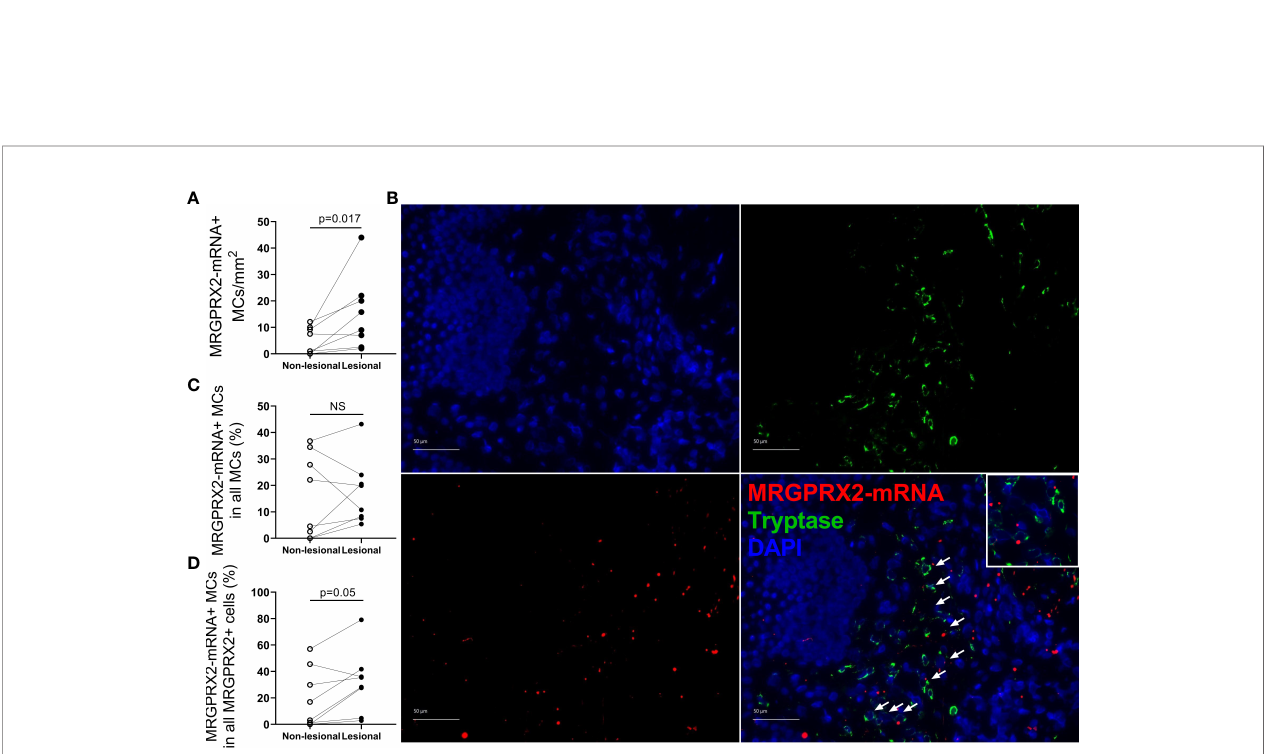
FIGURE 3 | The number of MRGPRX2-mRNA-expressing mast cells is increased in lesional skin of patients with indolent systemic mastocytosis. (A) Number of MRGPRX2-mRNA+ MCs in lesional and non-lesional skin of ISM patients. (B) In situ hybridization (MRGPRX2-mRNA) (red) and immuno fl uorescence (tryptase) (green) double staining in lesional skin of a patient with ISM #12 (MRGPRX2-mRNA+MCs are shown by white arrows). ×400 magni fi cation. Bar = 50 µm. (C) The percentage of MRGPRX2-mRNA+ MCs in all MCs in lesional and non-lesional skin of ISM patients. (D) The percentage of MRGPRX2-mRNA+ MCs in all MRGPRX- mRNA+ cells in lesional and non-lesional skin of ISM patients. ISM, indolent systemic mastocytosis; MC, mast cell.